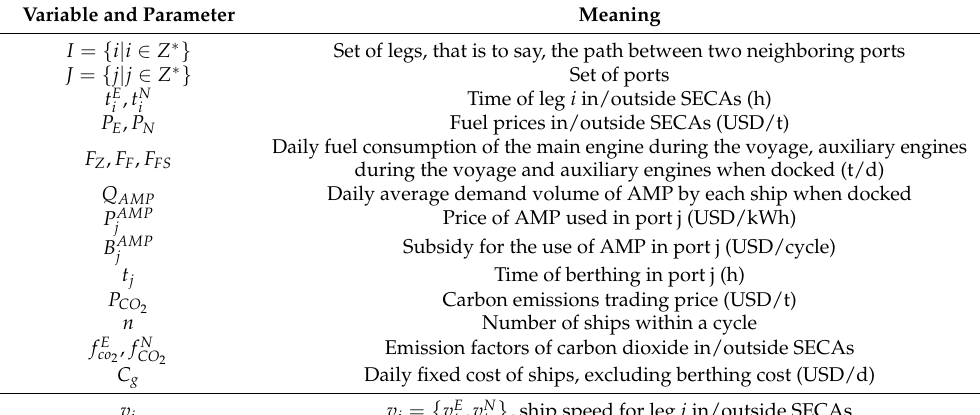
Table 1. Variables and